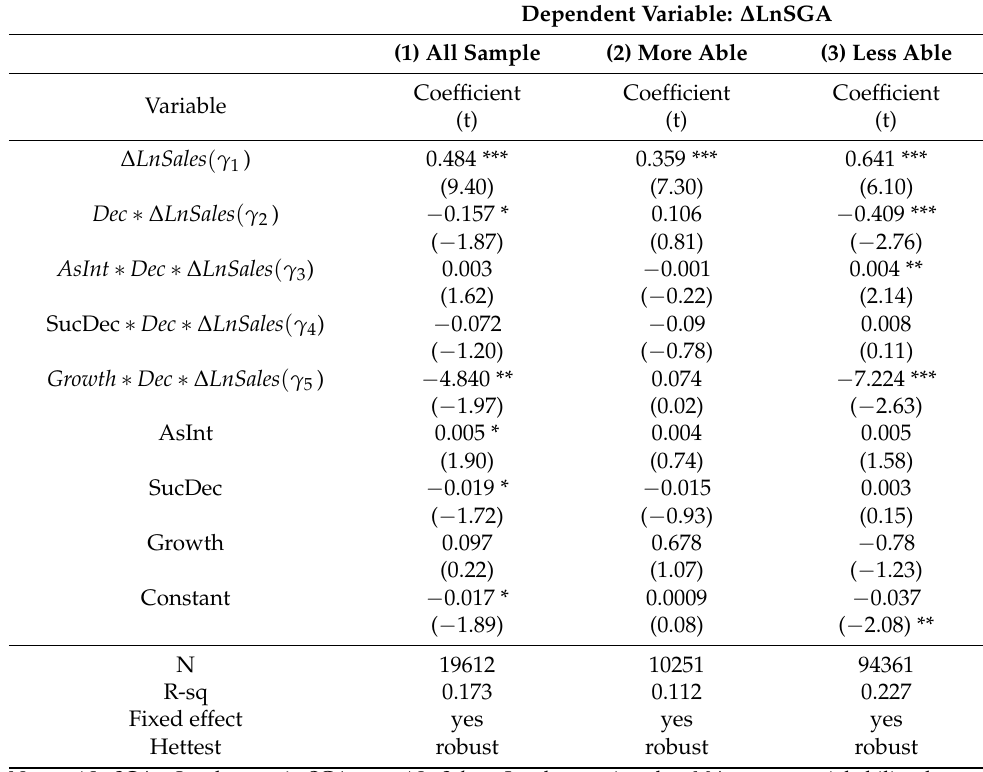
Table 6. Results of the Regression Analysis: Hypothesis